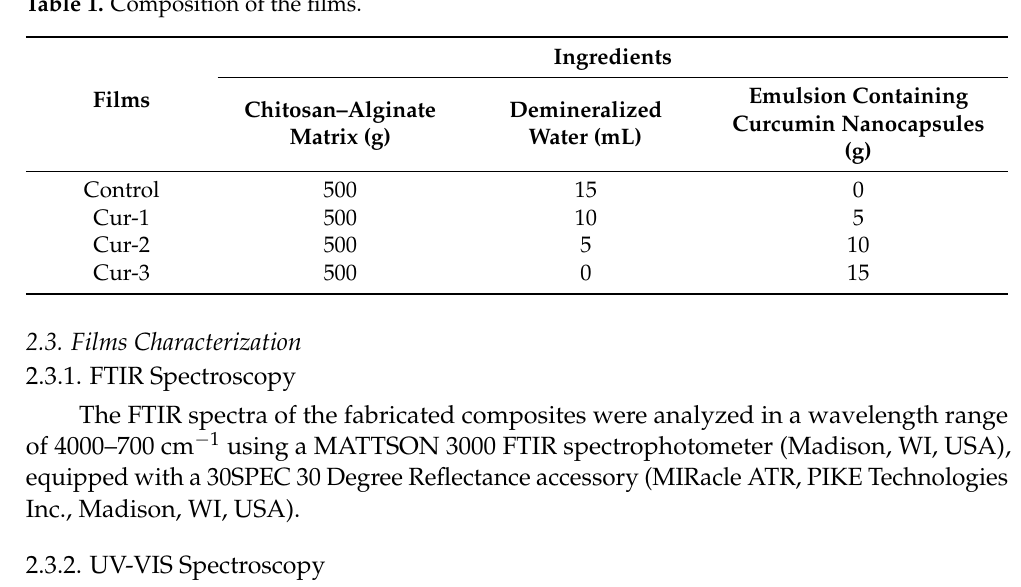
Table 1. Composition of the